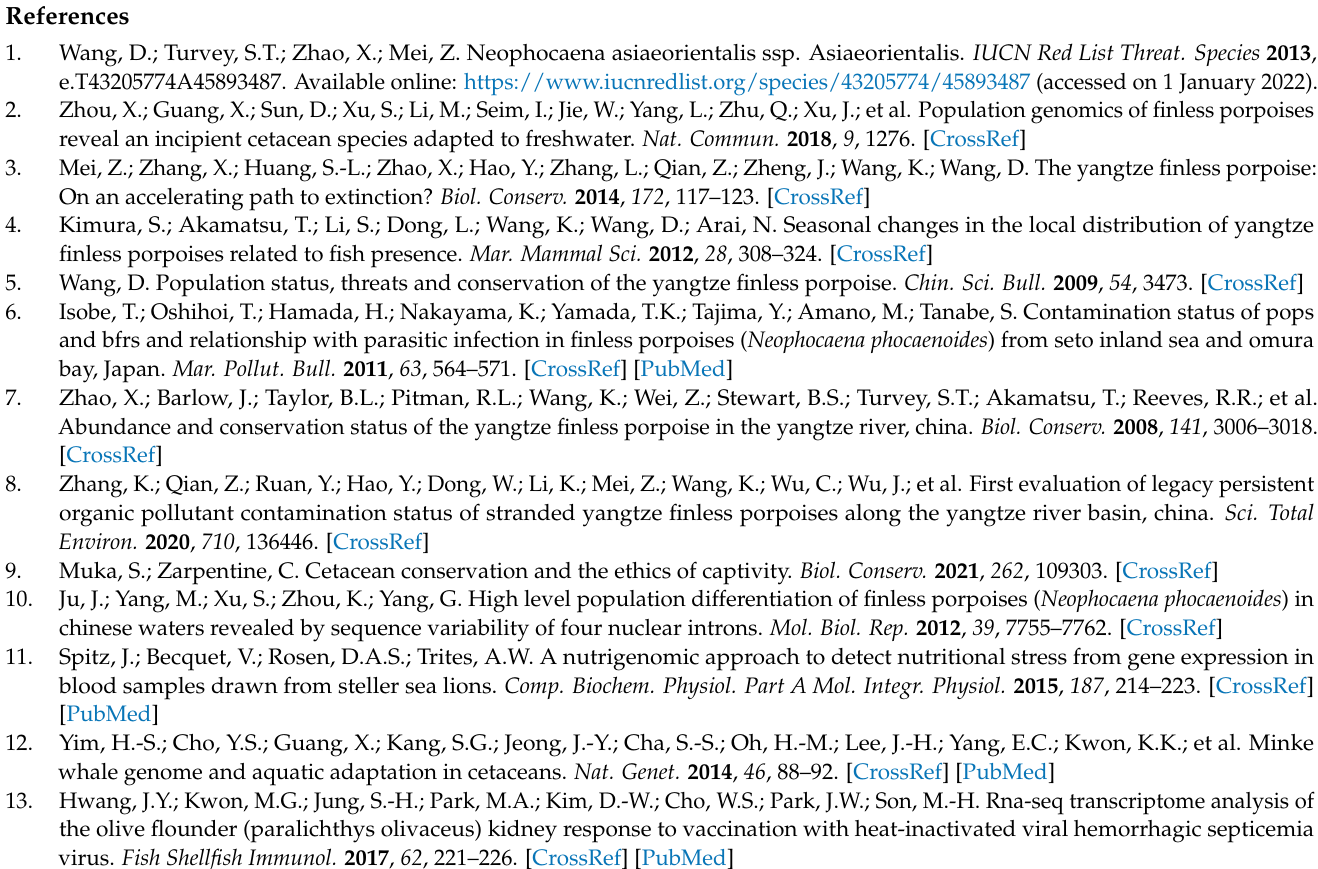
Table S5: Expression level of genes, Table S6: KEGG genes between male and